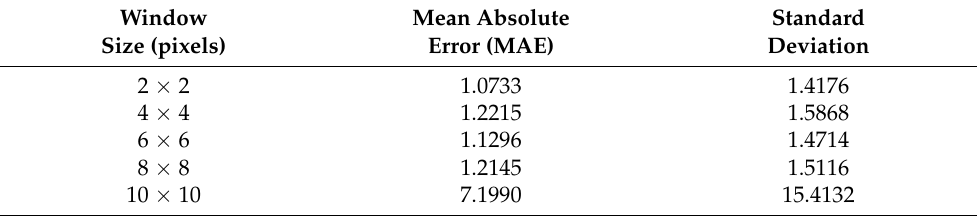
Table 1. Influence of measurement window size for reference speed